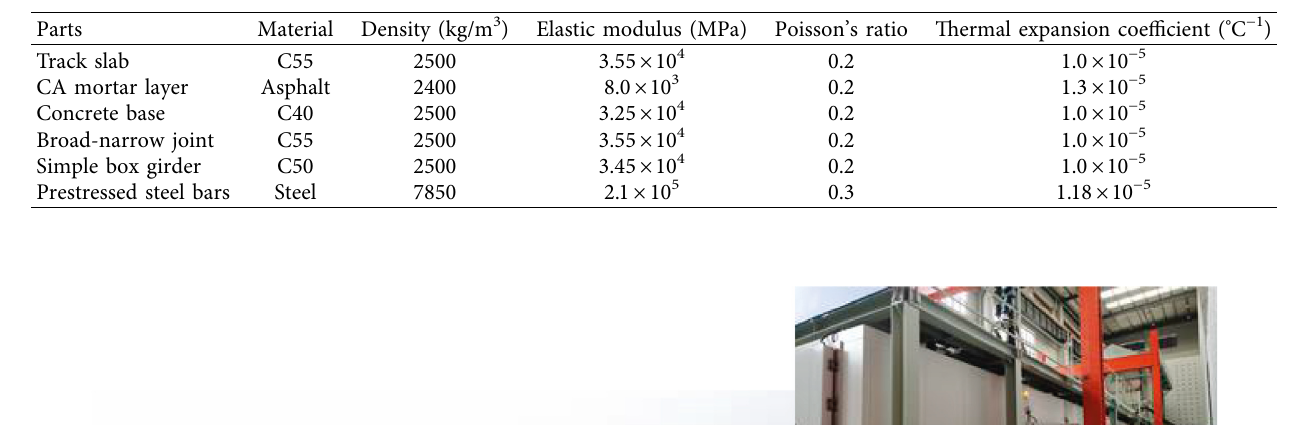
Table 4: Material parameters of the scaled specimen.